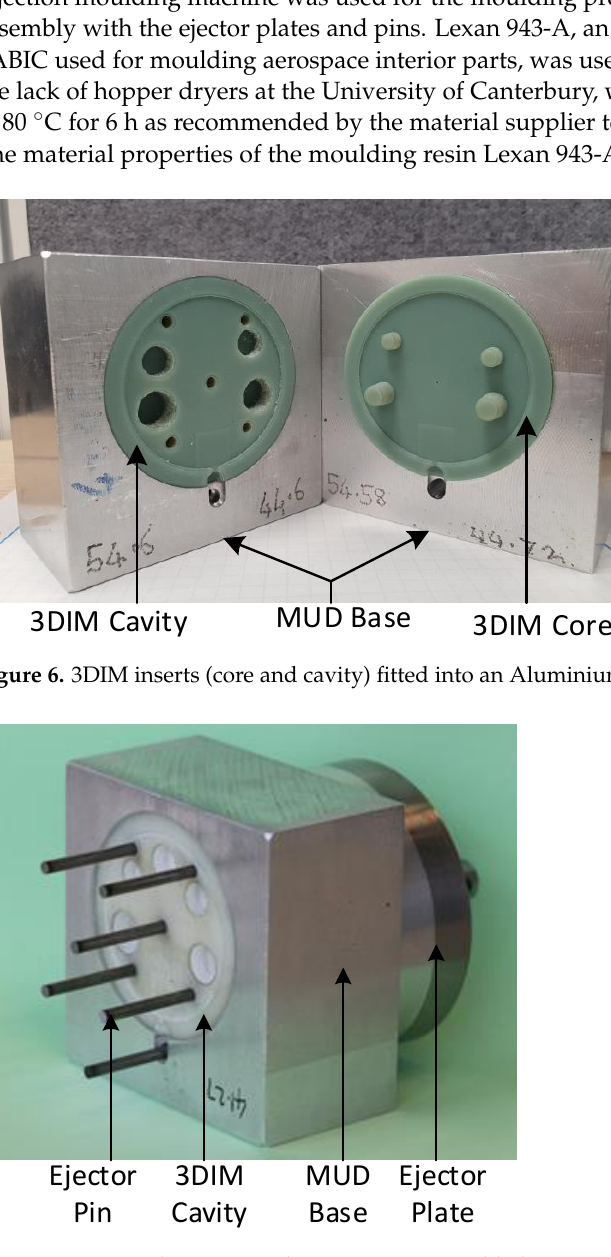
Figure 7. Ejector plate, pins and 3DIM insert assembled into MUD base. Table 3. Material Properties of Lexan 943-A.